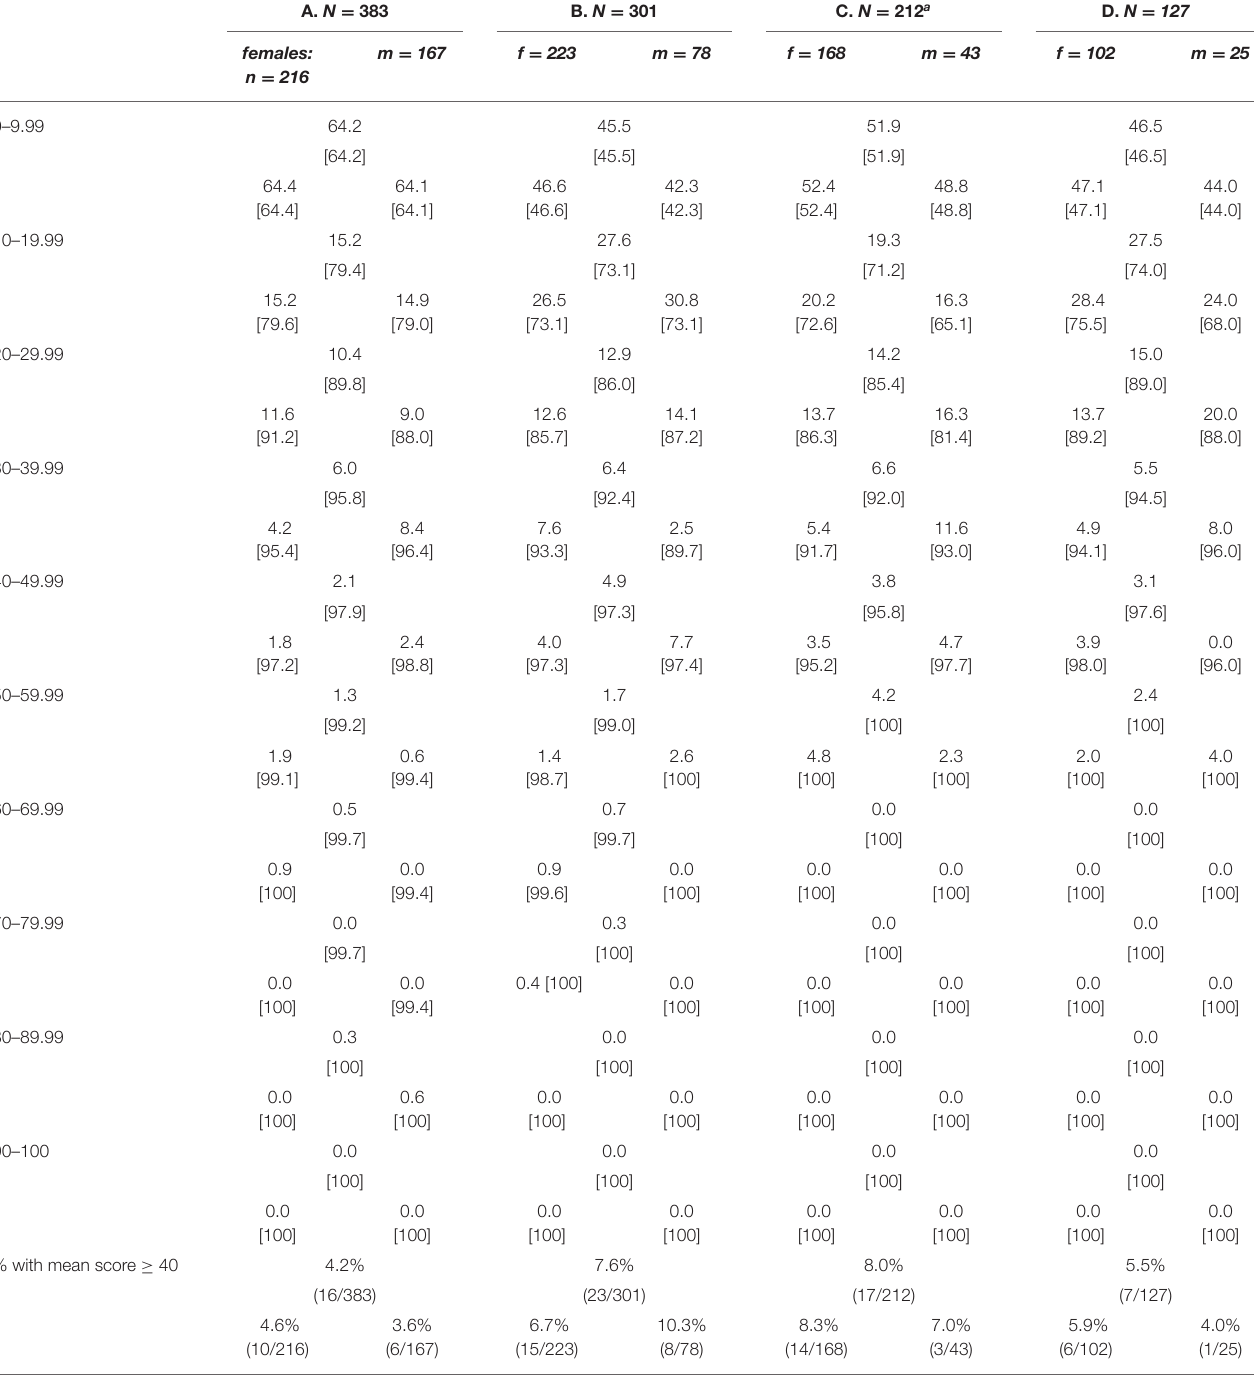
TABLE 2 | Distribution of mean MDS-16 scores across samples A-D (in percentages of respondents), and in the bottom row, distribution of suspected MD across samples A-D (in percentages), according to a cutoff of 40 on the